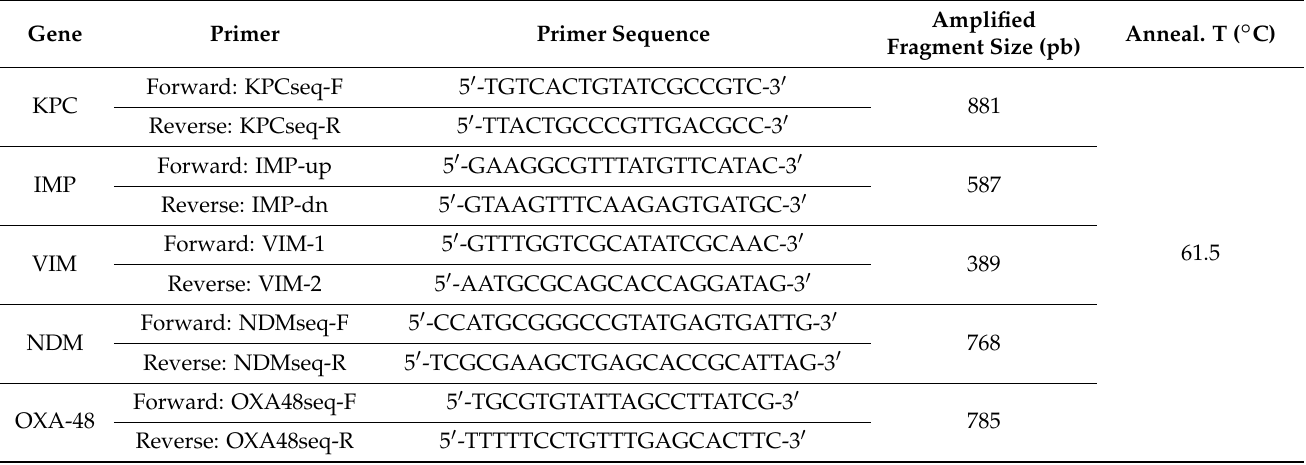
Table 1. The primers used for the amplification of commonly identified carbapenemases in our media (KPC, IMP, VIM, NDM, and OXA-48).